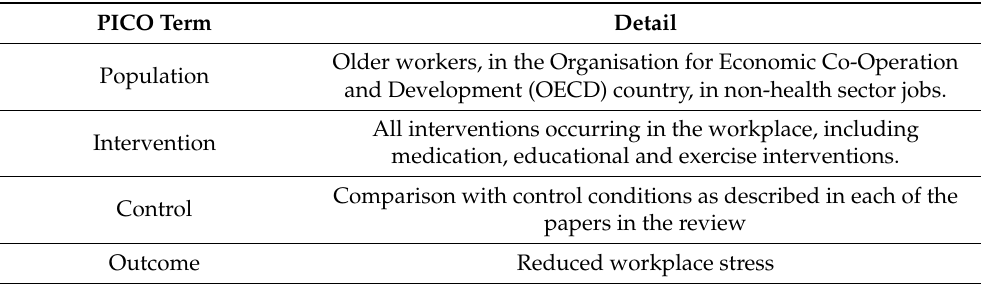
Table 1. The PICO model.